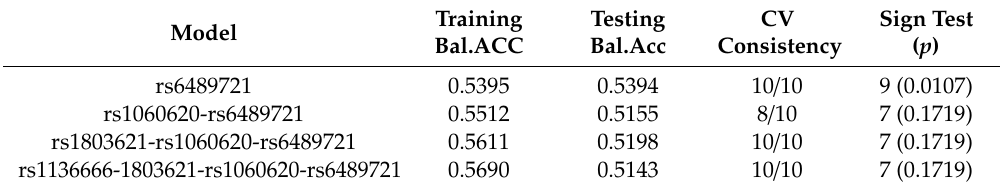
Table 8. MDR analysis of the interactions among the four SNPs.